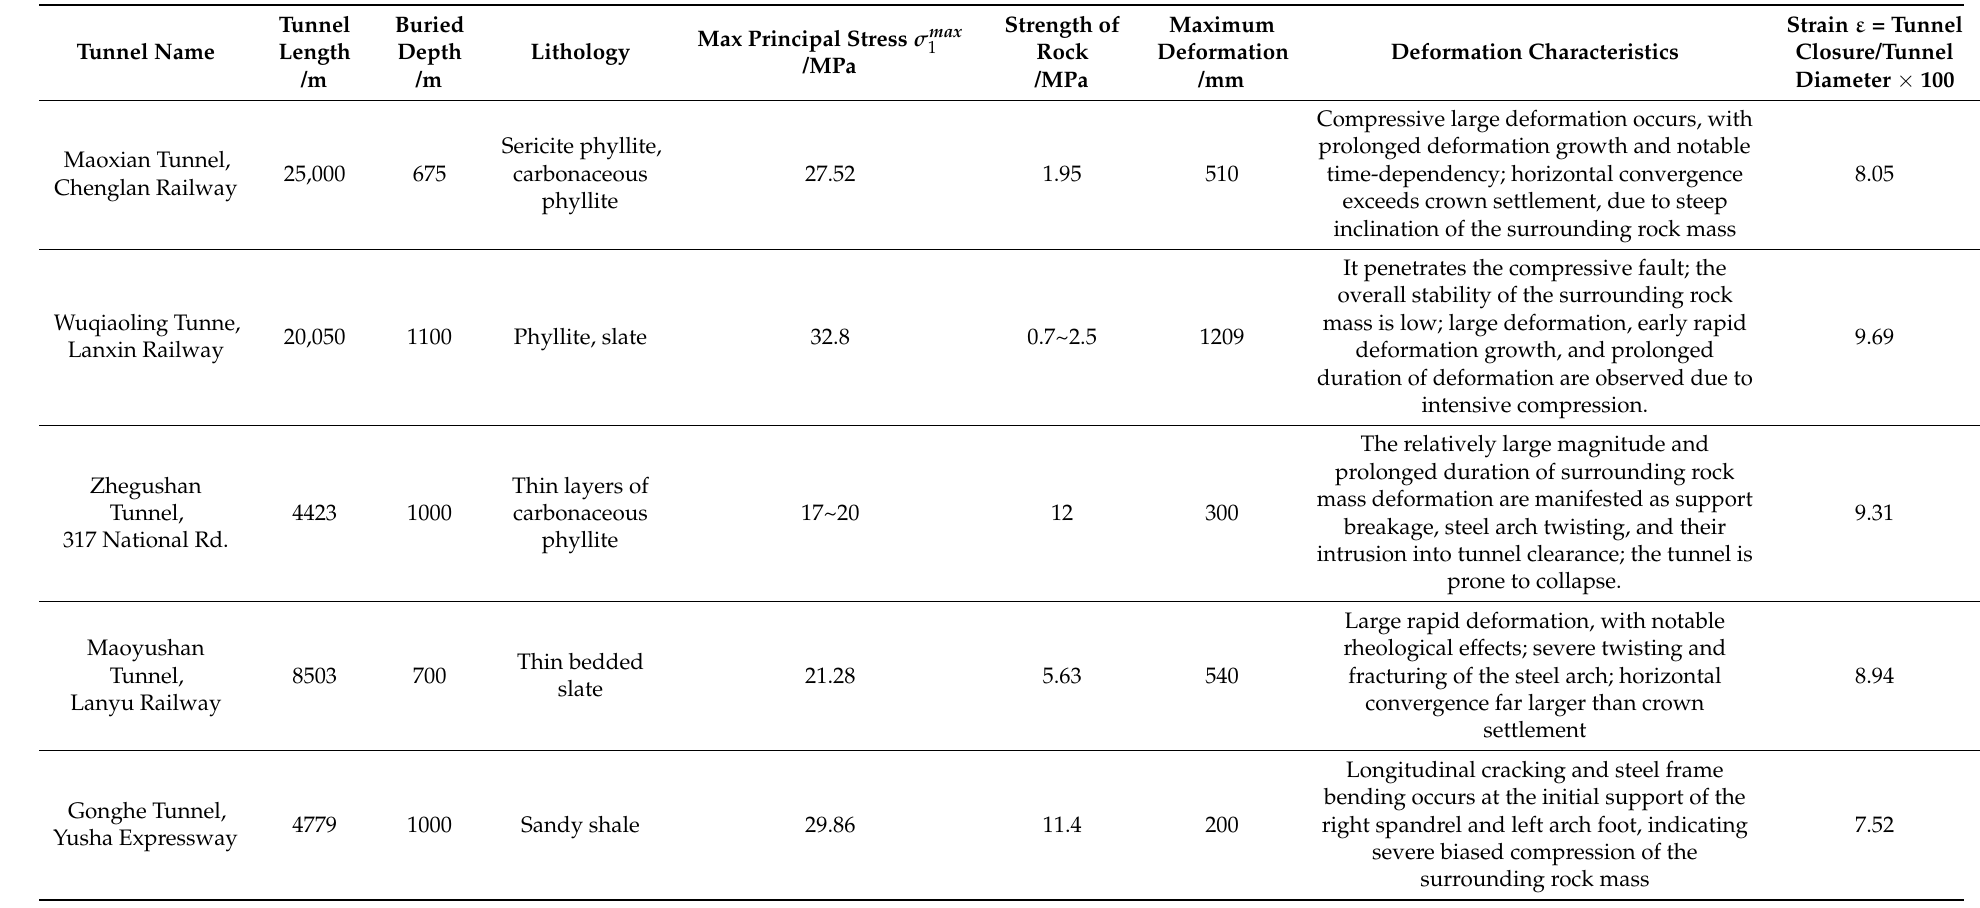
Table 1. Deformation-failure characteristics of tunnels’ surrounding rock masses and support structures under complex geological conditions in western